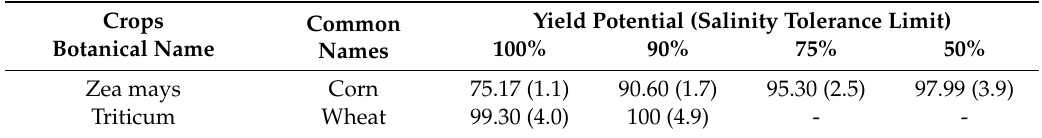
Table 6. Yield potential of Wheat and Corn